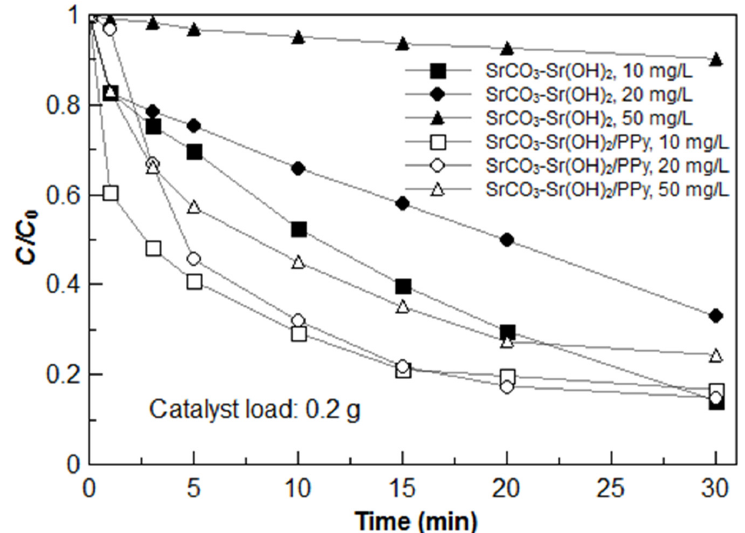
Figure 7. Kinetics of MB dye photodegradation under visible light irradiation using SrCO 3 ‐ Sr(OH) 2 and SrCO 3 ‐ Sr(OH) 2 /PPy nanocomposites for the MB initial concentrations indicated in the label. The catalyst load was 0.2 g for each case.